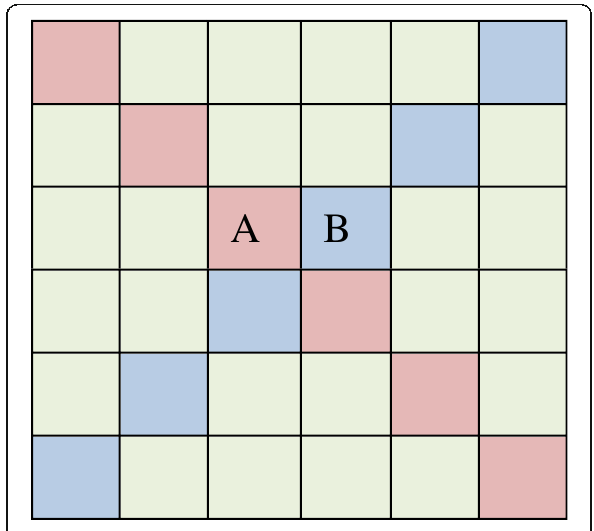
Fig. 1 Illustration of subsets A and B for asymmetry